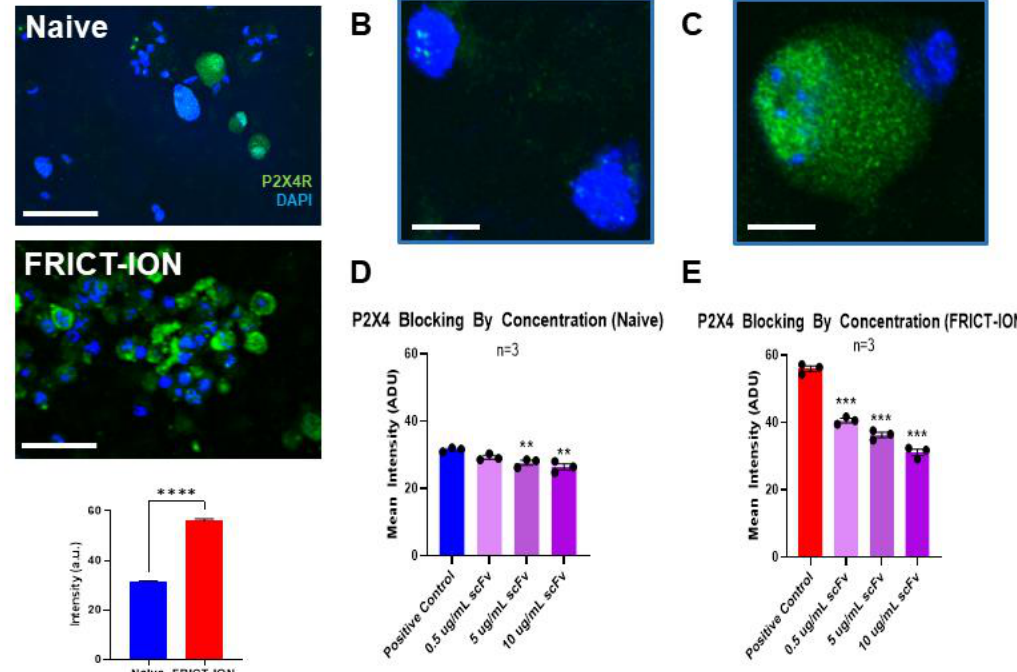
Figure 9. Pre-block of TG neurons with P2X4R scFv95. Low-power images of neurons immunostained for P2X4R (green) are shown in ( A ) for TG isolated from naïve and FRICT-ION mice. The bar graph of arbitrary staining intensity indicates the significant increase P2X4R in TG of mice with FRICT-ION compared to naïve. ( B ). At high power minimal P2X4R is found sequestered in vesicular structures in the TG of naïve mice. ( C ). Abundant staining for P2X4R is found in TG neurons isolated from FRICT-ION mice. ( D ). Pre-block with scFv 95 (0.5, 5,10 µ g/mL, 24 h) significantly diminished P2X4R staining intensity in TG from naïve mice. ( E ). TG cells from mice with FRICT-ION pre-treated with P2X4R scFv95 had significantly diminished P2X4R staining intensity with all pre-block dilutions tested. All images are shown with DAPI blue counterstain. scFv. n = 4. ** p < 0.01, *** p < 0.001, and **** p < 0.0001. Bar = 50 µ m in ( A ) and 6 µ m in ( B , C ).